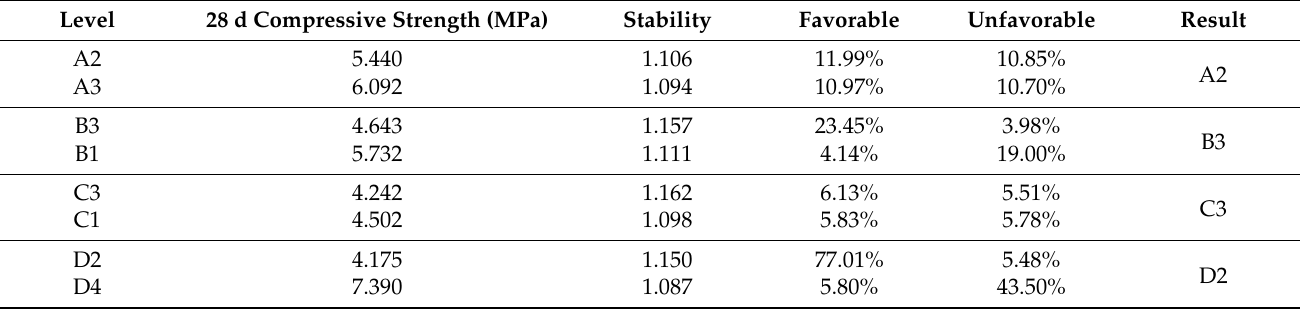
Table 6. Comprehensive balance analysis table of